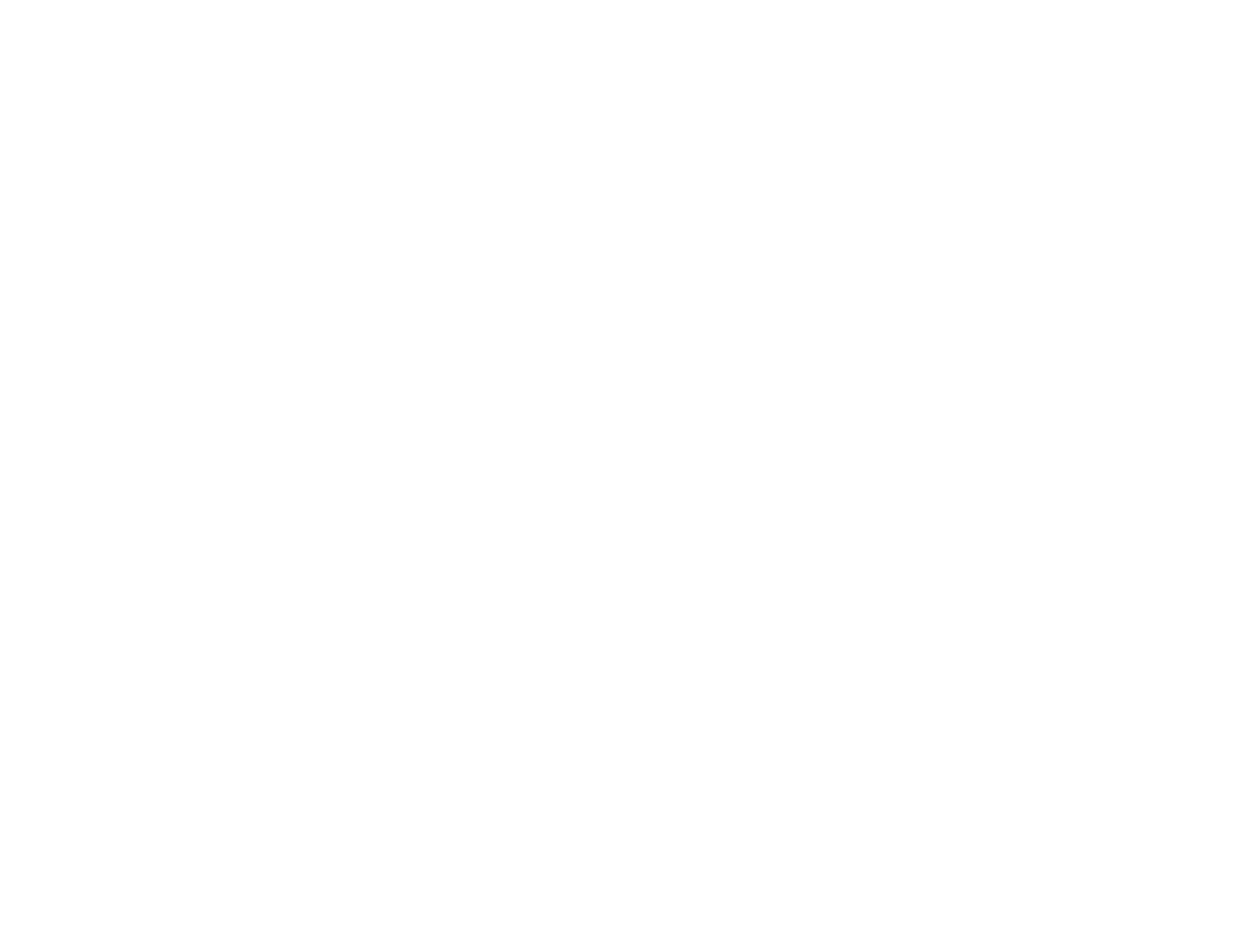
and Zn in a 30 µ m thick longitudinal section of Arabidopsis dry seed are separately. The associated STIM image shows the local mass of the sample. Scale bar: 100 µ